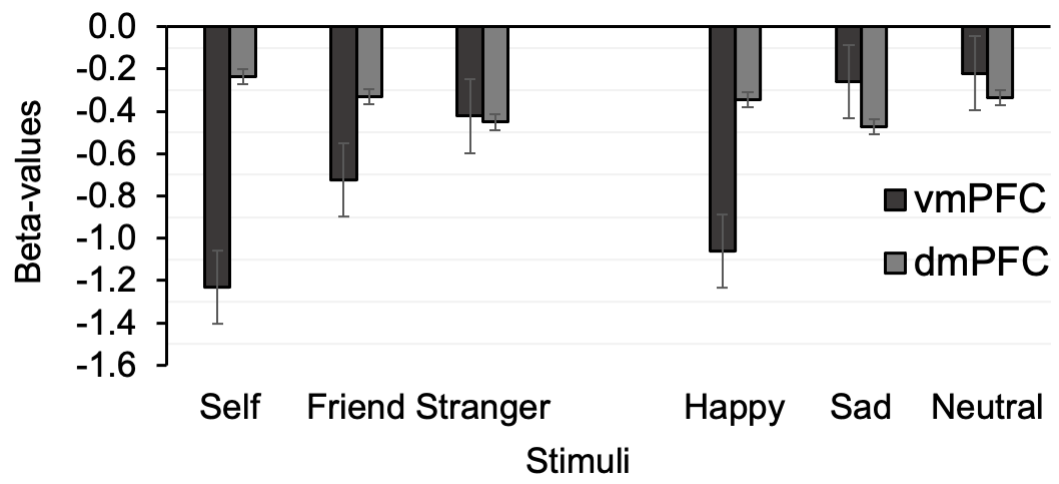
Figure 4. Mean beta estimates in the vmPFC and dorsomedial prefrontal cortex (dmPFC) regions of interest (ROIs). Error bars represent ± SEM.